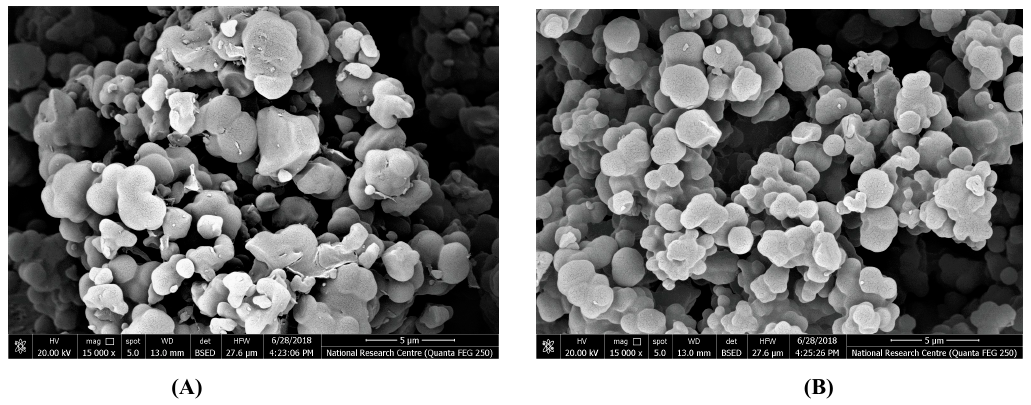
Figure 2. Scanning electron microscope ( SEM) images of ( A ) non-imprinted polymer (NIP) beads and ( B ) washed MIP beads.